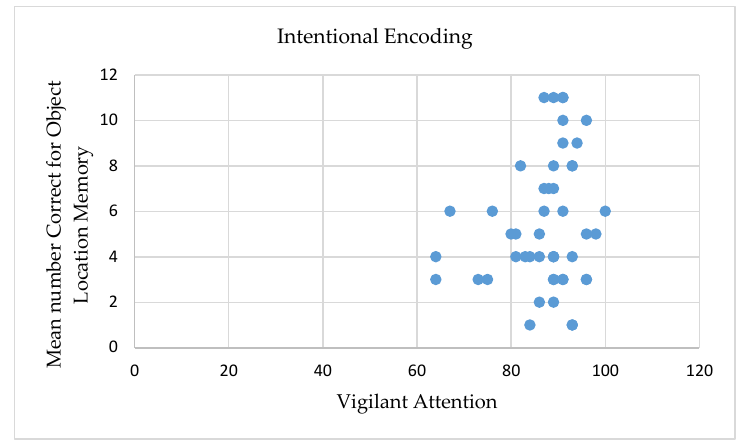
Figure 4. Mean number of correctly detected location-exchanged objects under the divided attention intentional encoding condition for the total scores as a function of vigilant attention (aggregate score).